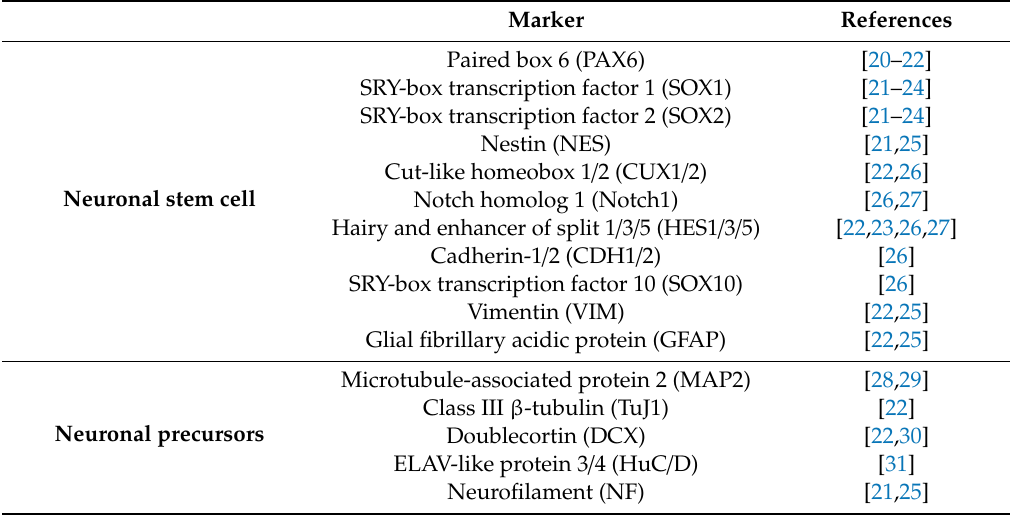
Table 1. Intracellular protein expression profile on NSCs and neuronal precursors. Specific sets of markers are useful to track di ff erentiation and discriminate between neural stem cells and committed neural precursors.